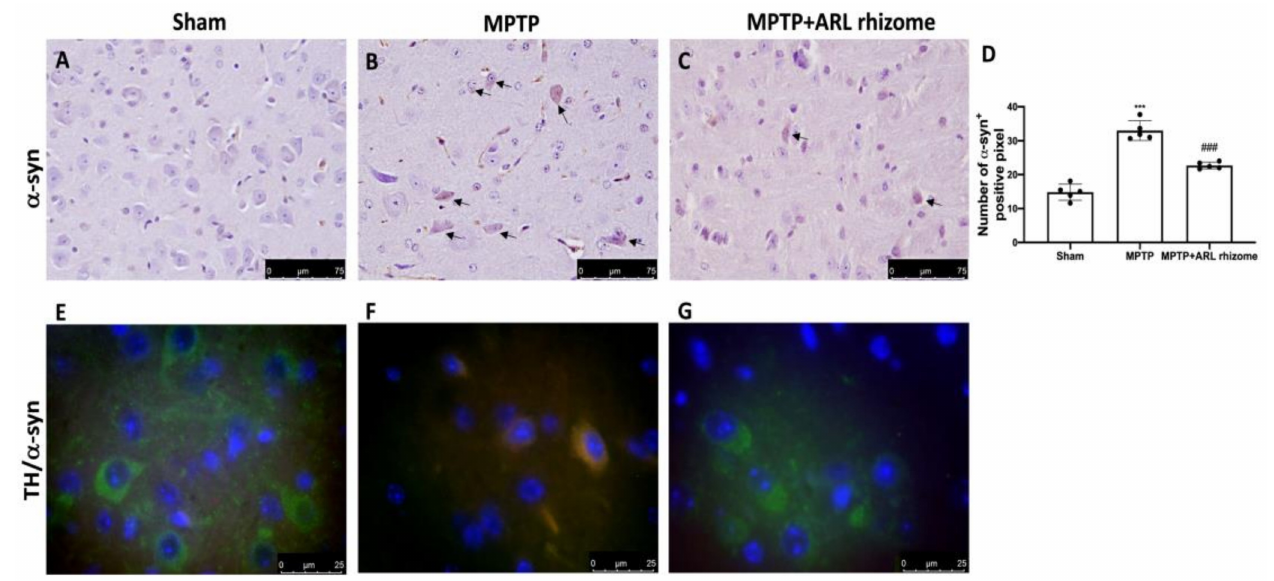
Figure 6. Effects of ARL rhizome on α -syn expression after MPTP-intoxication. Immunohistochem- istry for α -syn was evaluated in Sham ( A ), MPTP ( B ) and MPTP + ARL rhizome ( C ). The results are expressed as number of a-syn + positive pixel ( D ). The images are figurative of at least three independent experiments. Immunofluorescence for TH and a-syn was evaluated in Sham ( E ), MPTP ( F ) and MPTP + ARL rhizome ( G ). Values = means ± SD of five animals in each group. *** p < 0.001 vs. Sham; ### p < 0.001 vs.